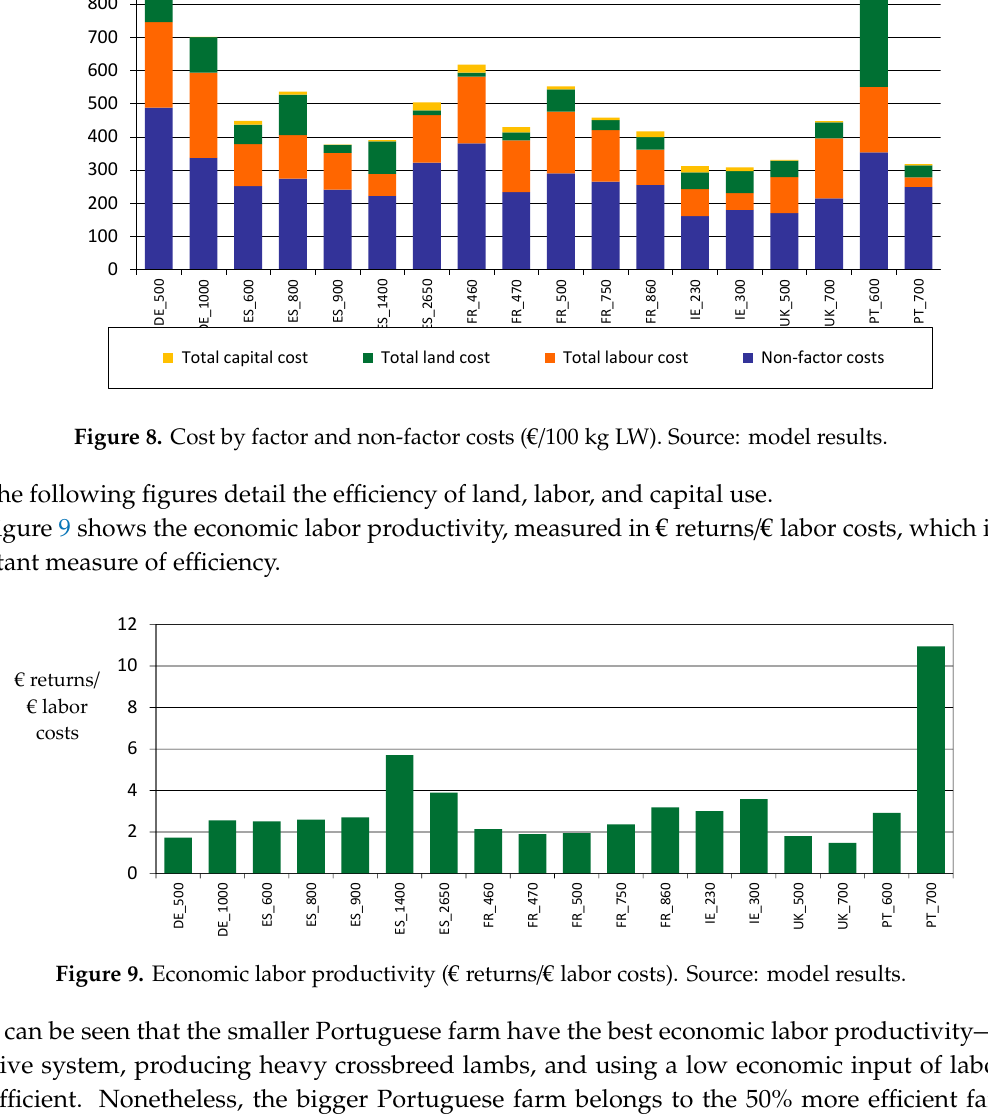
9 of 15 Figure 7. Total LW sold (per ewe (kg) and per kg of breeding ewe (kg LW/100 kg ewe). Source: model results. 3.2.2. Resources’ Use Efficiency